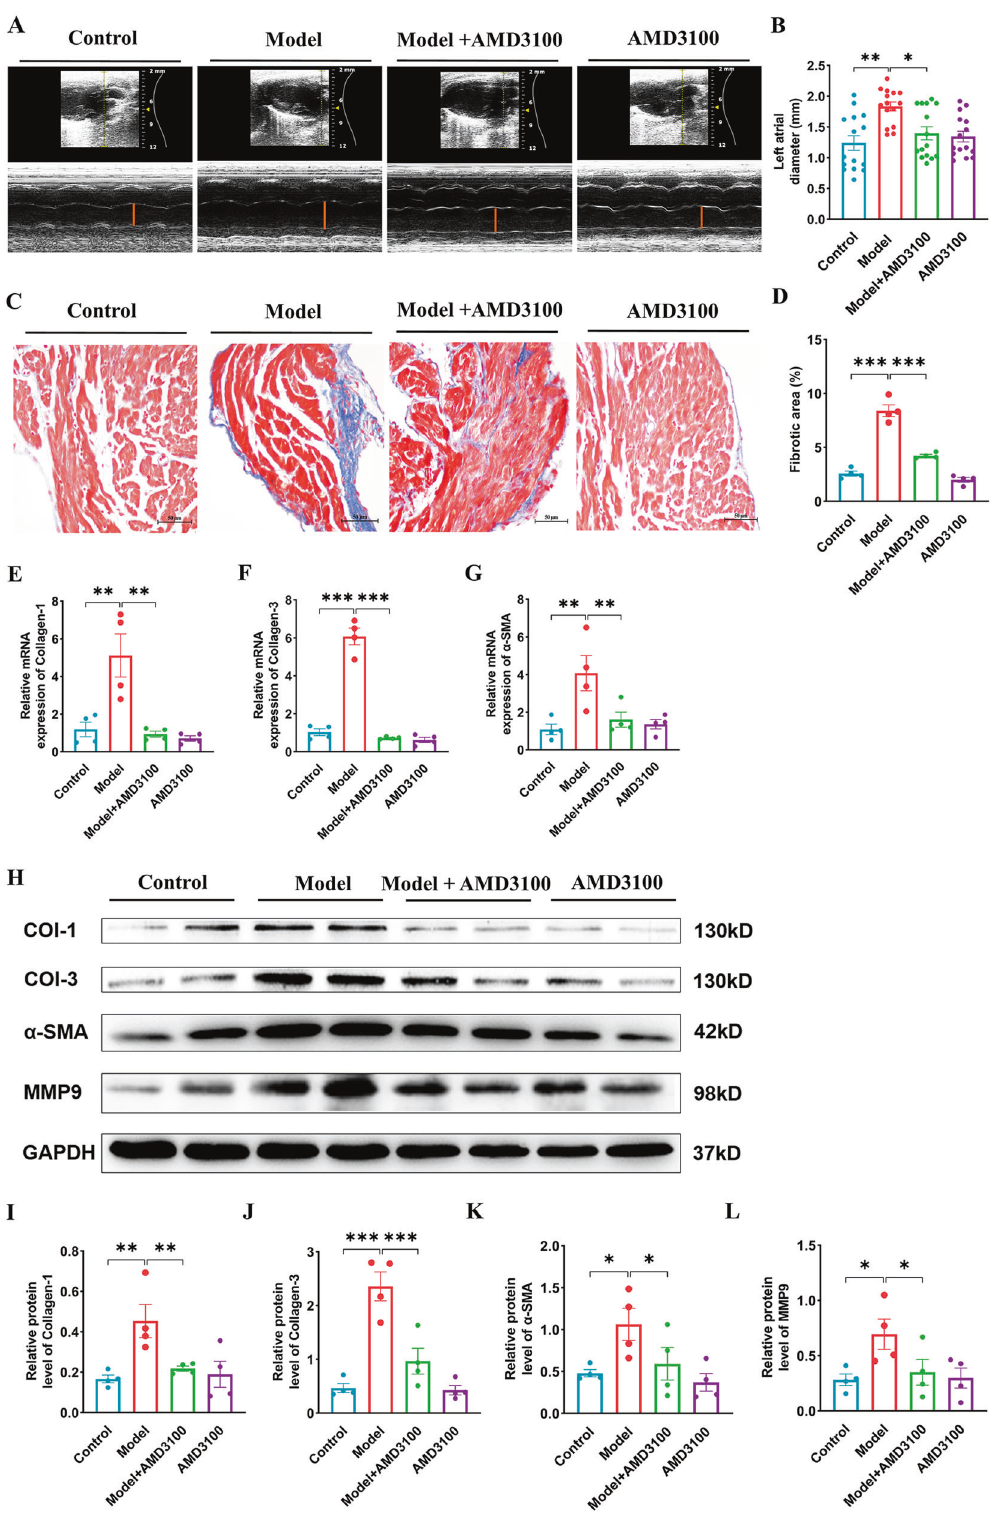
Fig. 4 AMD3100 administration prevents atrial structural remodeling. A – B The M-mode echocardiography of the left atrial chamber (left) and the quanti fi cation of left atrial diameter ( n = 15). C – D Collagen deposition in left atrial sections detected by Masson ’ s trichrome staining (left). Quanti fi cation of fi brotic areas ( n = 4). E – G The qPCR analysis of the mRNA levels of α -SMA, collagen -1, and collagen-3 in the atria from four groups ( n = 4). H – L Immunoblotting analysis of α -SMA, collagen -1, and collagen-3 and MMP9 protein levels in the atria (upper). Quanti fi cation of each protein band (lower, n = 4). GAPDH was used as an internal control. Scale bar: 50 μ m. Results are expressed as the mean ± SEM, and n represents the number of animals in each group. * P < 0.05, ** P < 0.01, *** P < 0.001.